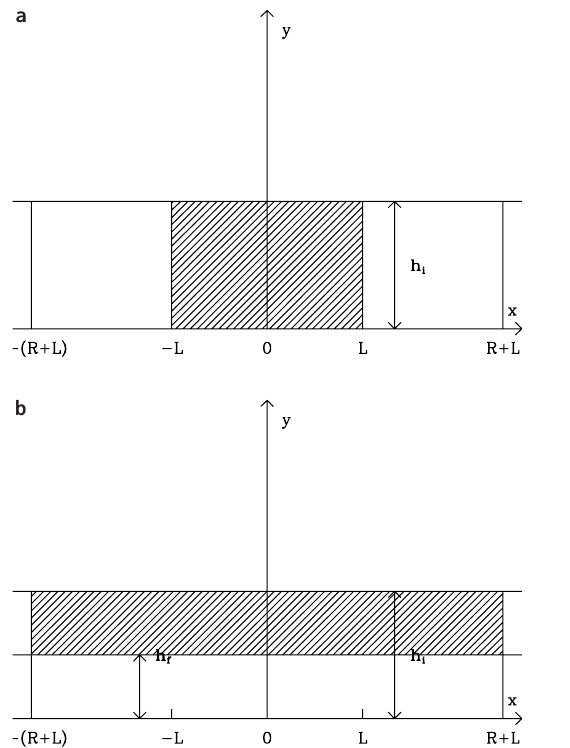
Fig. 3. a Air masses in a heated boundary layer over a flat peninsula. h i is the initial boundary layer depth, 2 L is the patch width and R is the Rossby radius. b As in a but after the adiabatic redistribution of air masses. h f is defined by mass conservation. R and L as in